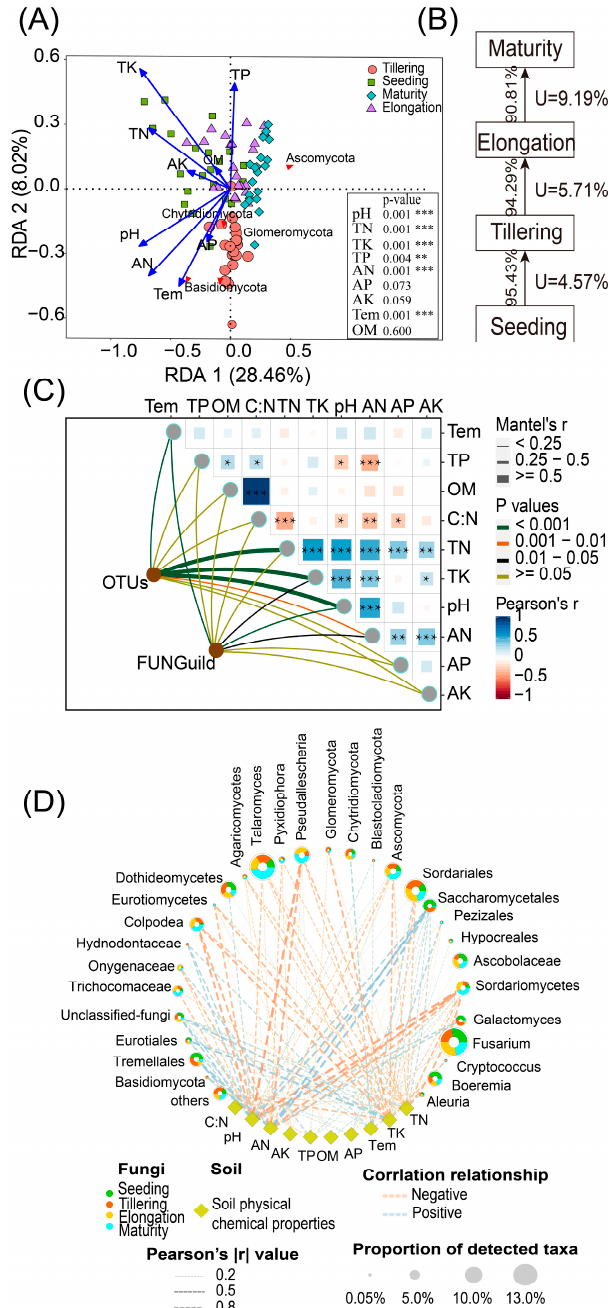
Figure 4. ( A ) Redundancy analysis (RDA) of soil properties and dominant Fungal phylum. In the part of the bottom right, the soil properties were fitted to the ordination plots using a 999 permutations test ( p -values), significance: *** p < 0.001, ** p < 0.01, * p < 0.05. ( B ) Source analysis of sugarcane rhizosphere microorganisms. Source environment proportions for 84 samples of different stages were estimated using the Source Model of Plant Microbiome (SMPM). The number represents the proportion of fungal transmission in the adjacent period, and the letter U represents the proportion of microorganisms from unknown sources. ( C ). Environmental drivers of sugarcane rhizosphere fungal community composition. Pairwise comparisons of environmental factors are shown, with a color gradient denoting Pearson’s correlation coefficients. Edge width corresponds to the Mantel’s r statistic for the corresponding distance correlations, and edge color denotes the statistical significance based on 9,99 permutations. ( D ). Co-occurrence network of the mainly fungus genus population and soil properties in rhizosphere